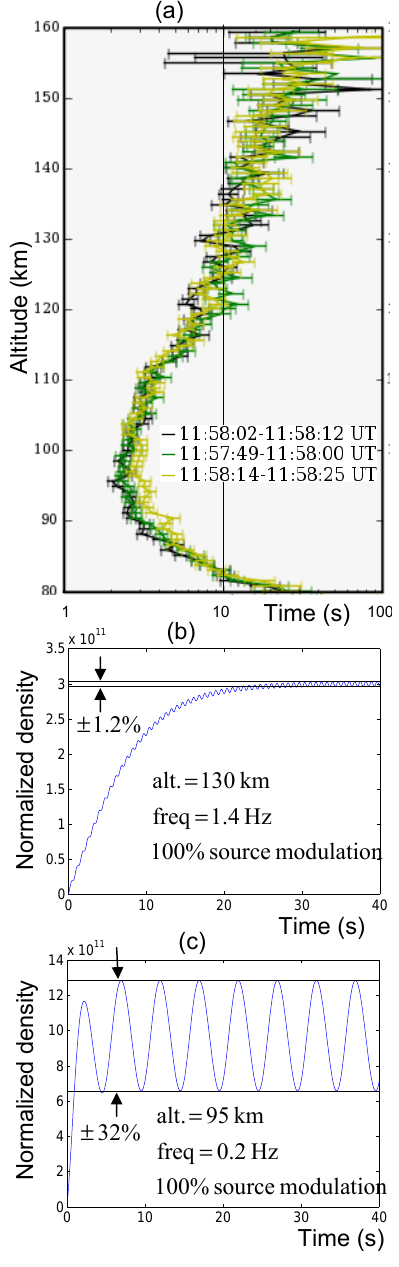
Fig. 8. (a) Recombination time scales from PFISR, (b) simulation of generation and recombination for 1.4Hz signal, (c) simulation of generation and recombination for 0.2Hz